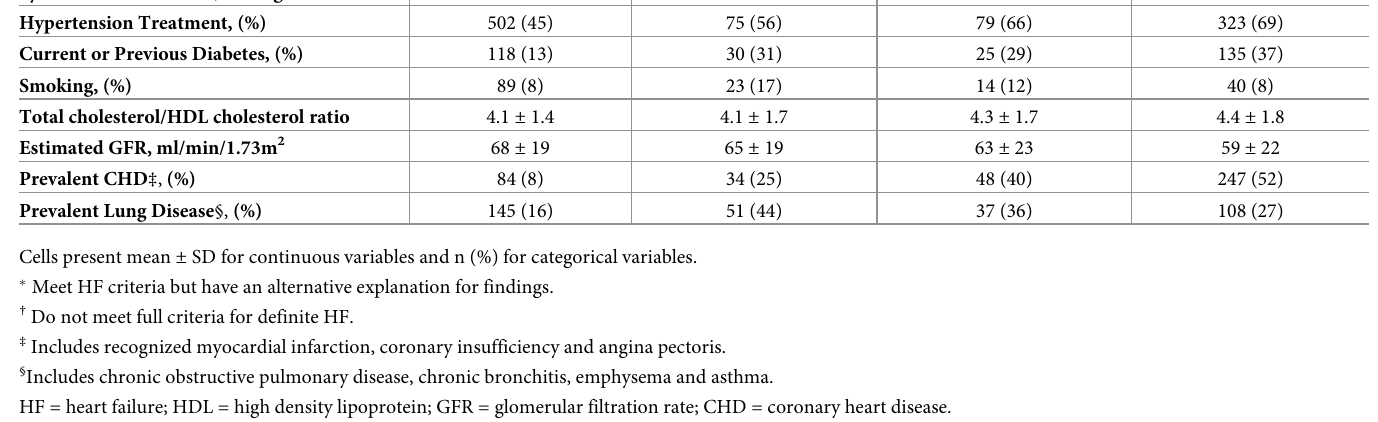
two-thirds were treated for hypertension and a third had diabetes. In all groups, mean eGFR was borderline normal. Probable and definite HF groups had a higher proportion of CHD, whereas the possible HF had higher proportions of smokers and prevalent lung disease. The various groups were followed up for mean 8.6 (maximum 28.3 years). Table 2 and S1 Table display proportions of incident events and causes of death during follow-up respectively. The proportion who developed definite HF was 3-fold higher in the probable HF group com- pared with controls, and 2-fold compared with the possible HF group. The proportions of CHD death were several-fold higher in the groups with probable and definite HF compared with possible HF or controls. In contrast, probable or definite HF had lower proportions of cancer death and other death compared with possible HF. Results from Cox regression models comparing possible and probable HF groups with con- trol group are shown in Table 3. For these comparisons, the assumption of proportionality of